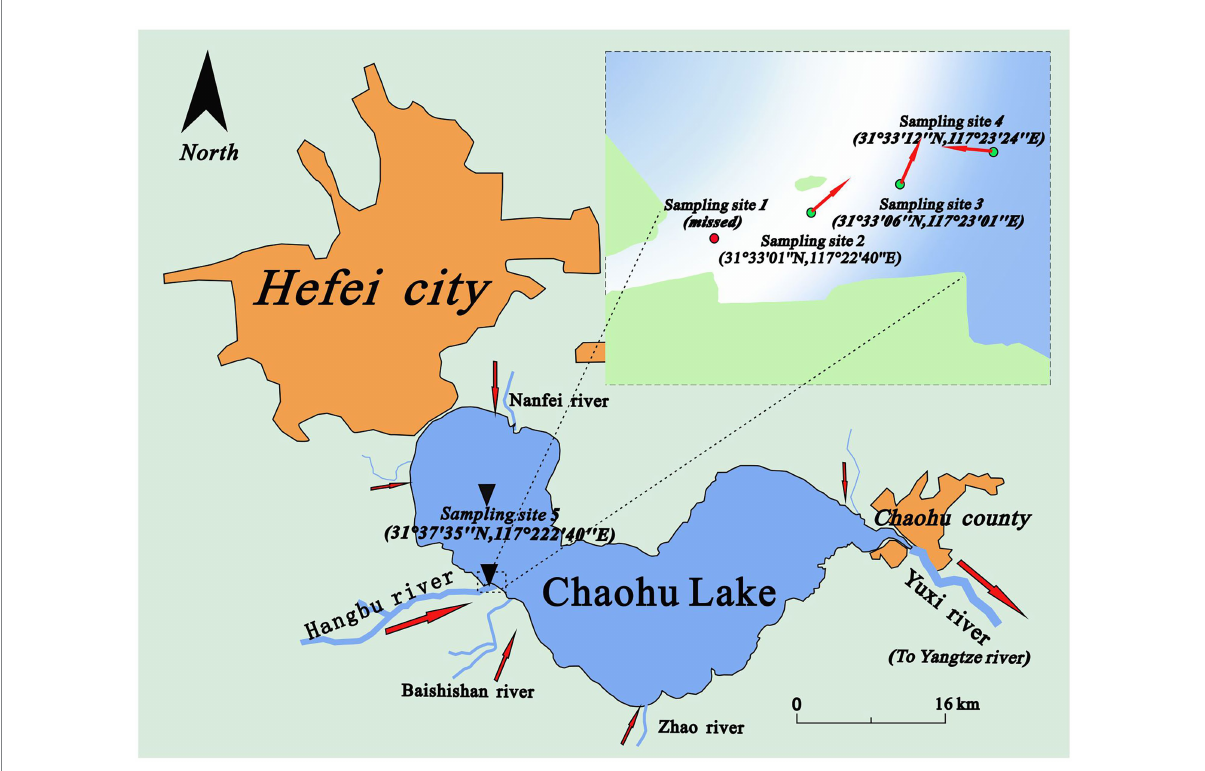
FIGURE 1 The locations of sampling sites (Sampling site 1 was upstream of site 2. The sediments there were nearly all composed of sand and could not be obtained by our sampling